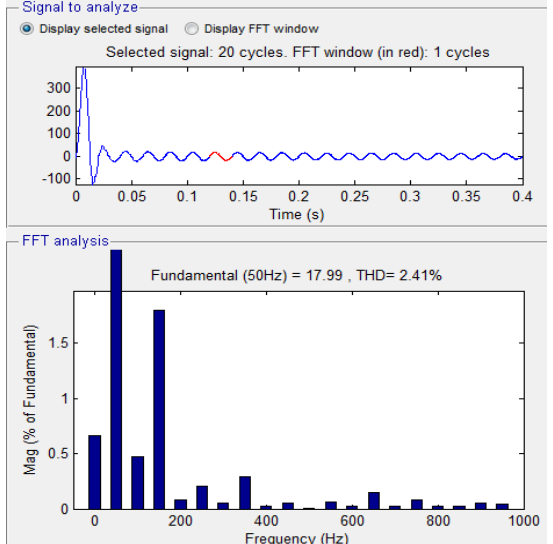
Figure 23. THD in source current